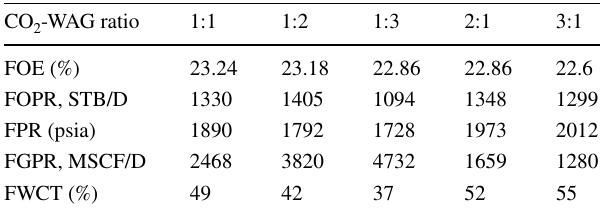
Table 11 Performance forecast of S3 reservoir considering different CO 2 -WAG